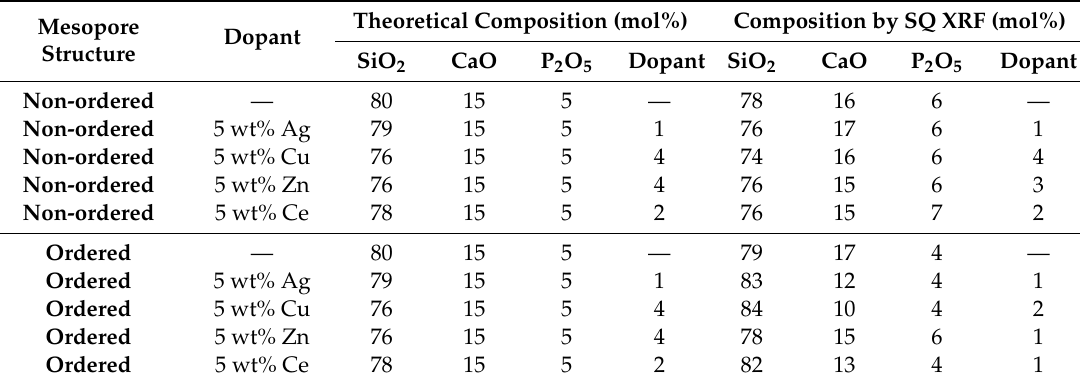
Table 5. Theoretical and experimental mol% compositions of mesoporous silicate